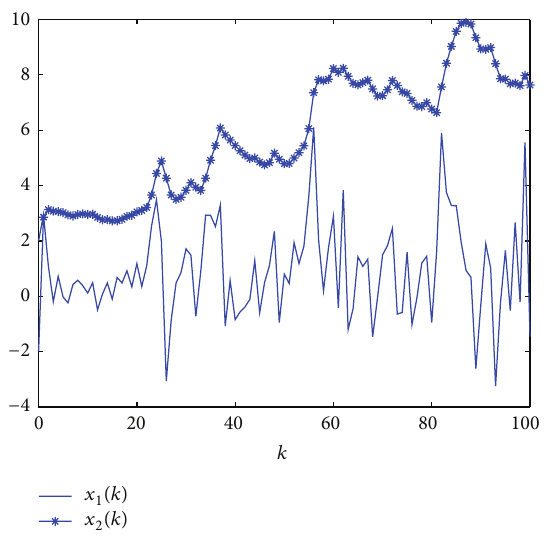
Figure 1: State evolution 𝑥(𝑘) of uncontrolled systems.